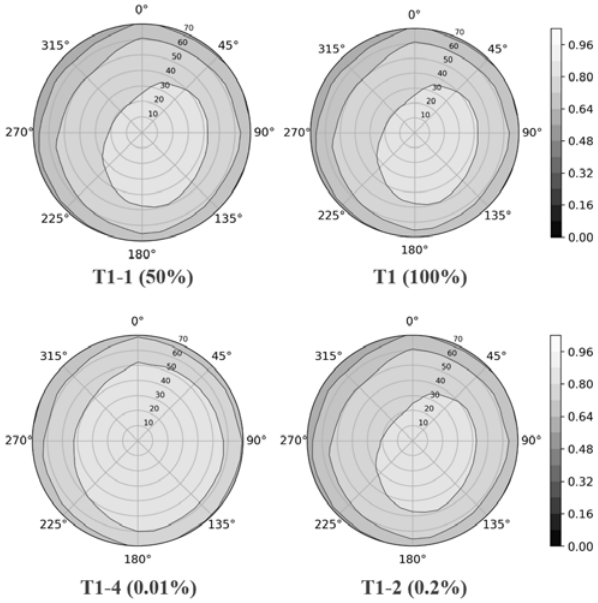
Figure 8. Gap fraction polar contour diagrams for the first stage (16 September 2019).